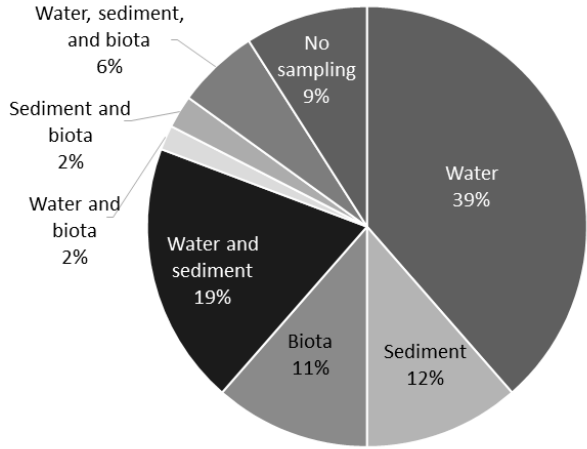
Figure 8. Sample categories investigated in the studies.